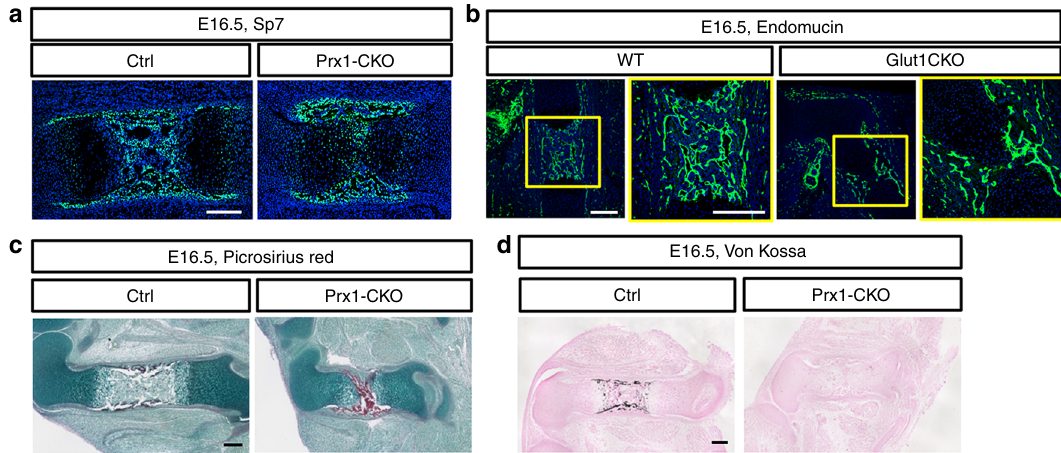
Fig. 5 Loss of Glut1 impedes mineralization of bone matrix at E16.5. a , b Immuno fl uorescence staining of Sp7 ( a ) or Endomucin ( b ) on longitudinal sections of the femur. c Picrosirius Red staining for collagen I. d von Kossa staining for minerals. Scale bar: 200 µ m. Each image is representative of three mice